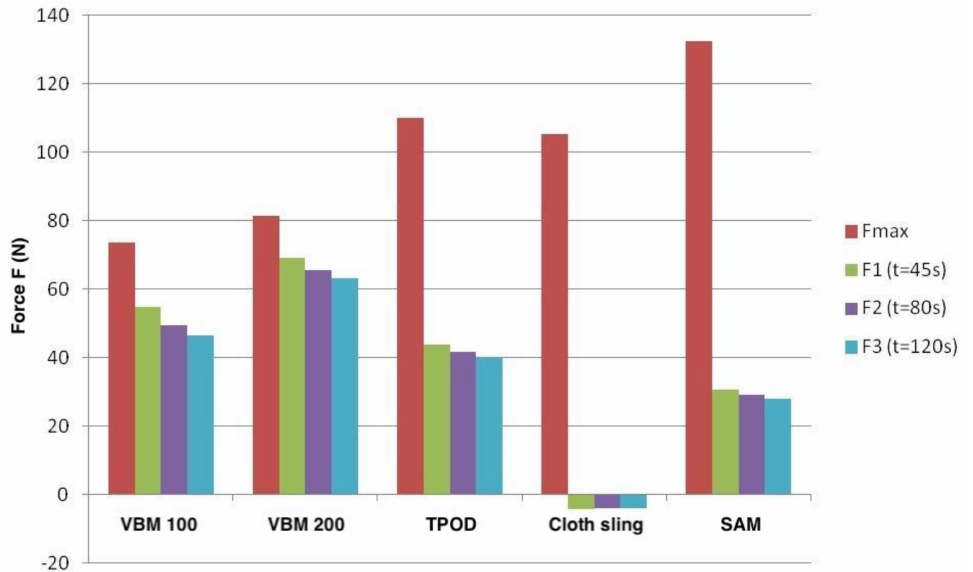
Figure 7. Kinetics of the pelvic stabilizers. Maximum and mean forces achieved at the various predefined times after application of the respective pelvic sling: The SAM Sling ® was able to achieve the highest peak tensile forces, but that these fell rapidly and disproportionately. The most constant tensile force of all pelvic slings at the time points examined was demonstrated by the VBM ® pneumatic pelvic sling with an applied pressure of 200 mmHg (source: Haussmann [22],